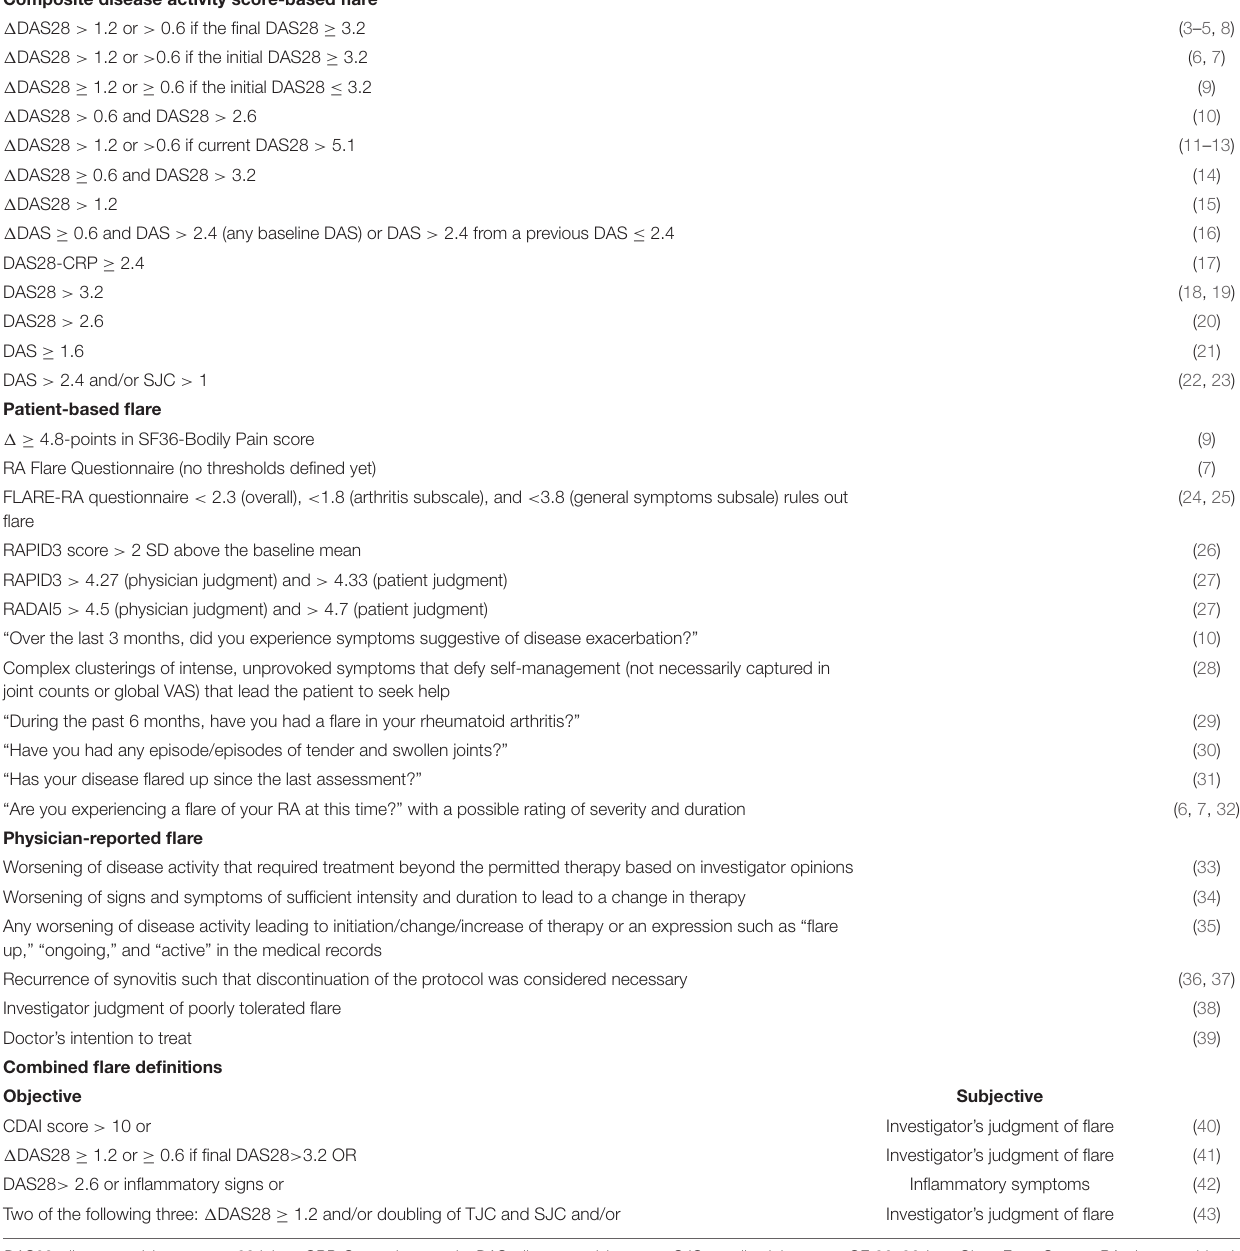
TABLE 1 | Rheumatoid arthritis flare definitions. Composite disease activity score-based